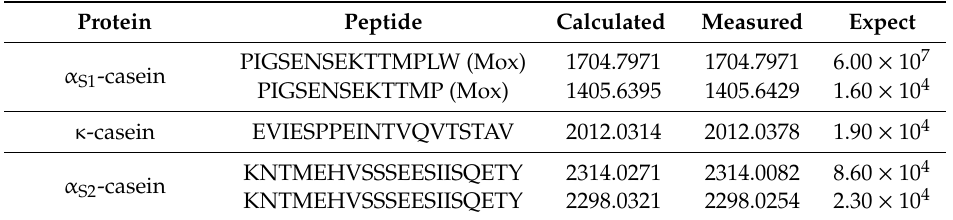
Table 1. Milk peptides transported over Caco-2 monolayers identified by Liquid Chromatography with tandem mass spectrometry (LC-MS / MS).